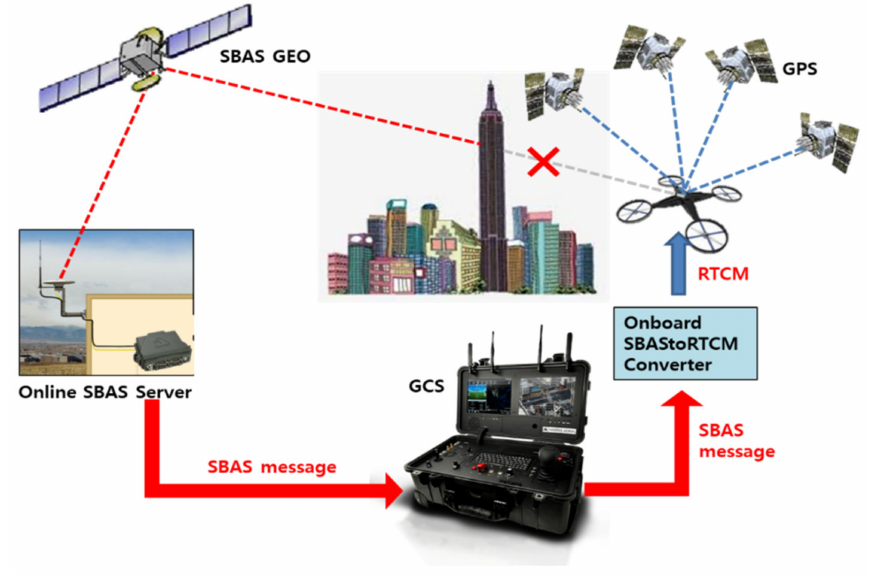
Figure 5. Online SBAS service concept for drone